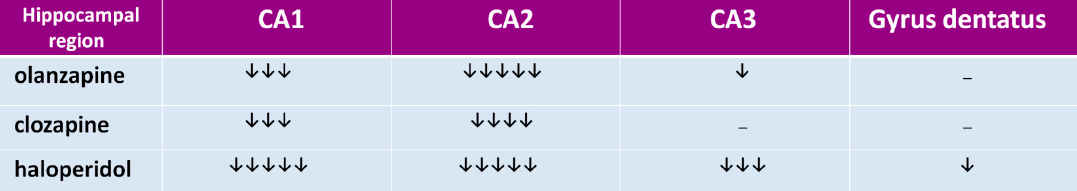
Figure 2. The influence of chronic antipsychotic drug administration on NMDA receptor subunits’ expression in CA1, CA2, and CA3 hippocampus regions and in gyrus dentatus in rats. Arrows indicate the subunit expression decrease by 0–25% ( ↓ ), 26–50% ( ↓↓ ), 51–75% ( ↓↓↓ ), and 76–100% ( ↓↓↓↓ ).